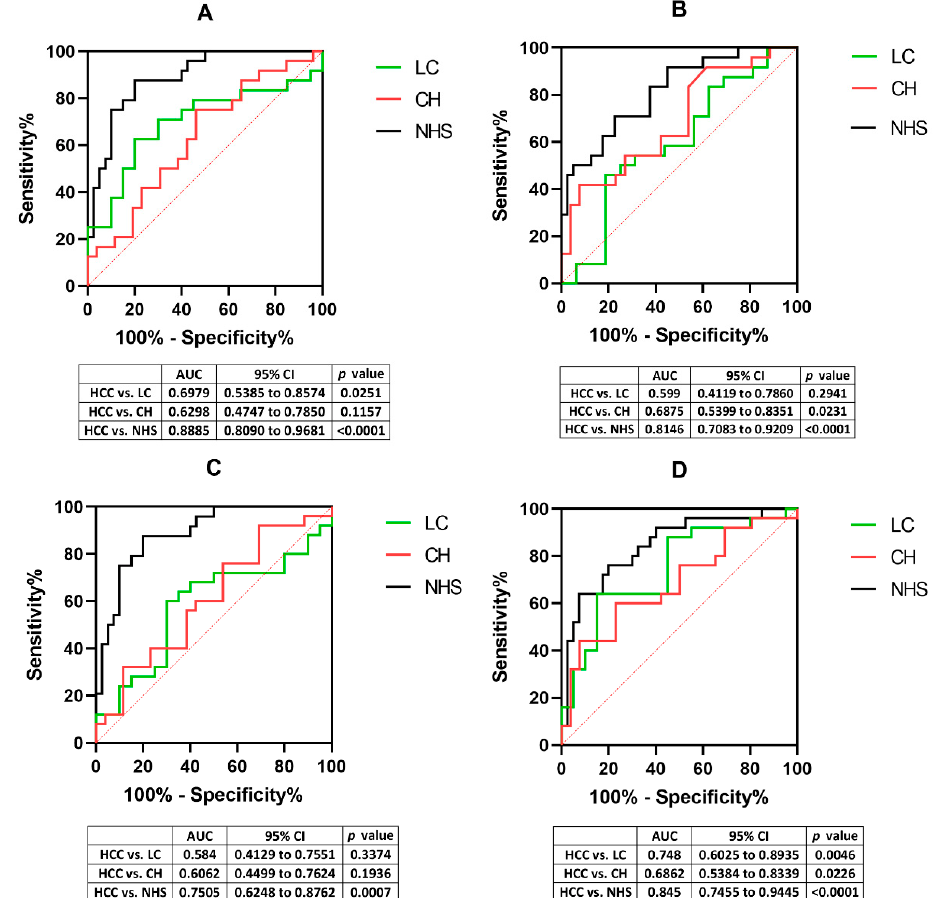
Figure 2. ROC analysis of anti-TAA autoantibodies between Hispanic HCC and LC, CH, and NHS groups. p value less than 0.05 indicates the confidence of the diagnostic model. ( A ) DNMT3A; ( B ) p16; ( C ) HSPA5; ( D ) HSP60. HCC: Hepatocellular carcinoma; LC: Liver Cirrhosis; CH: Chronic Hepatitis; NHS: Normal Healthy Sera. AUC: area under the receiver operating characteristic (ROC) curve.